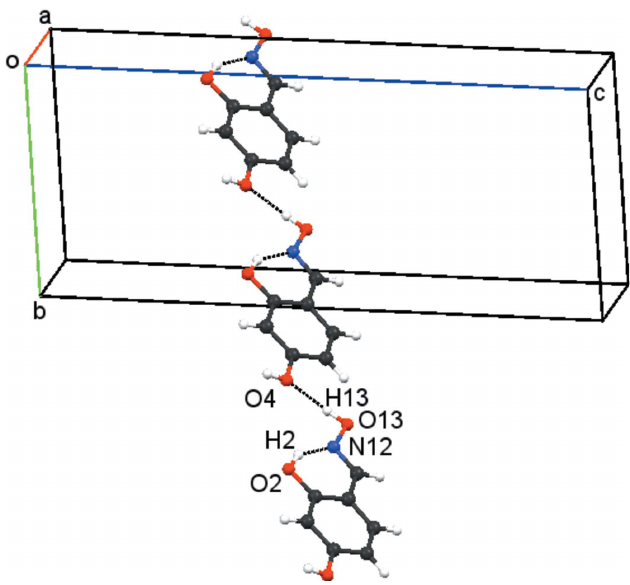
Figure 5 Compound 2 . Part of a C 9 chain, propagating in the b- axis direction,